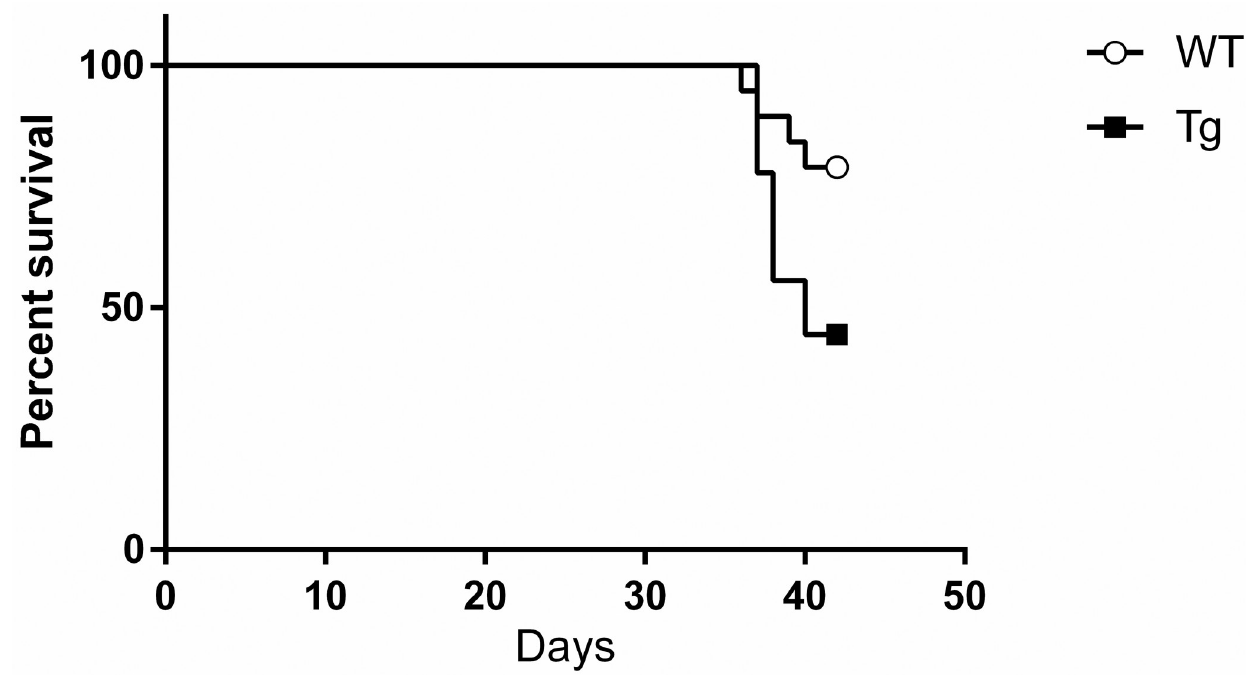
Fig 2. Animal survival. CTRP3 Tg mice trended towards a reduced rate of survival compared with that of WT mice (78% in WT versus 44% in CTRP3 Tg, p = 0.07). Survival data was compared by the Mantel-Cox test; n = 18 and 9, WT and Tg respectively. Abbreviations: CTRP3, C1q tumor necrosis factor- related protein-3; Tg transgenic overexpression of CTRP3; WT, Wildtype.